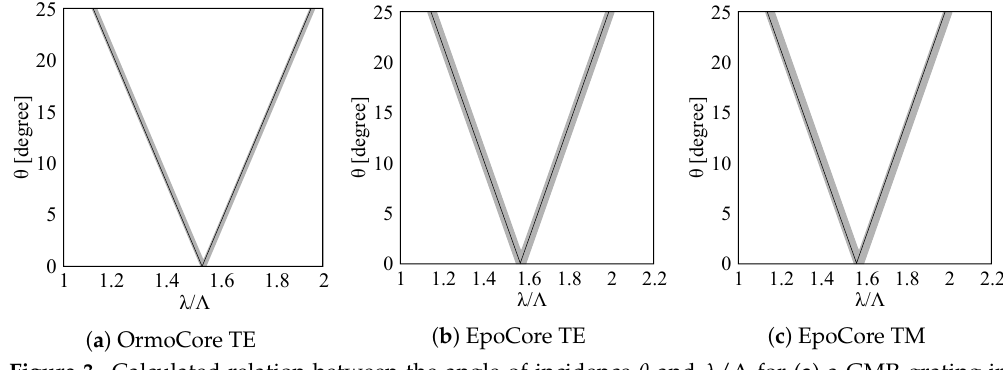
Figure 3. Calculated relation between the angle of incidence θ and λ / Λ for ( a ) a GMR grating in OrmoCore and ( b , c ) a GMR grating in EpoCore. The used grating parameters are listed in Table 1. Table 1. Structure parameters for the GMR gratings in OrmoCore and EpoCore. The given RI values are for a wavelength of 850 nm [33–35].